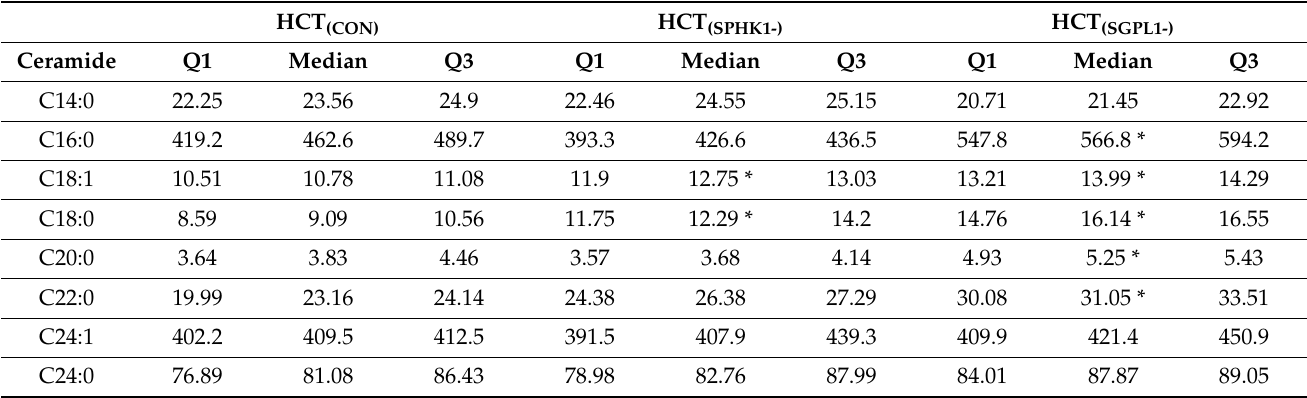
Table 1. Composition of individual Cer molecular species in SPHK1 - and SGPL1 -gene-silenced human colorectal tumor HCT-116